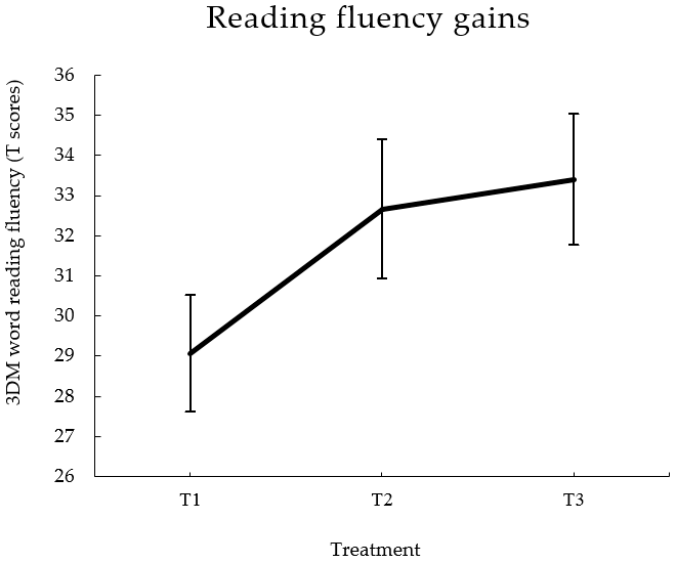
Figure 2. Reading fluency scores (3DM total T scores; words and pseudowords combined) before starting training (T1), after the letter-speech sound training (T2), and after completion of the full remedial program (T3).